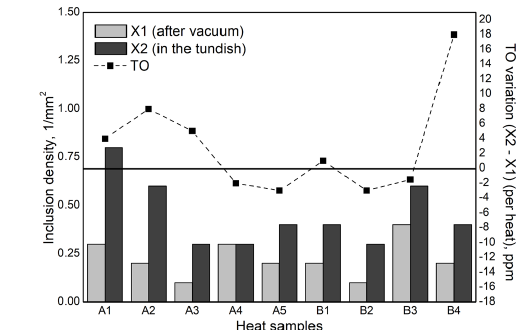
Figure 8. Comparison between the inclusion density and the total oxygen variations content in samples X1 (after vacuum) and X2 (in the tundish).